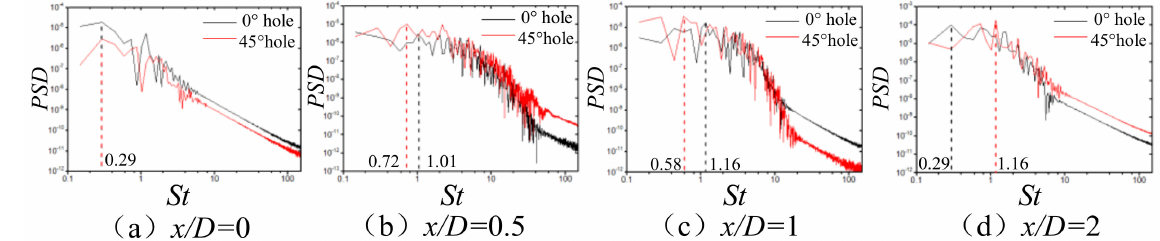
Figure 18. Spectrum of temperature fluctuations at different positions on the impact target